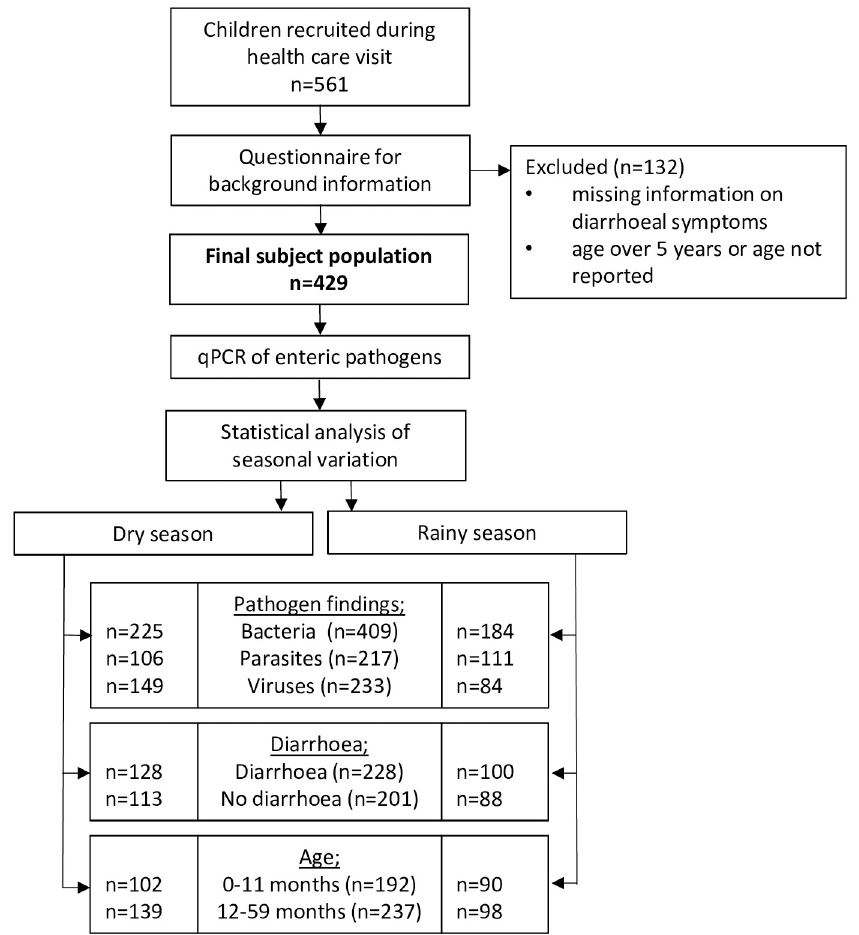
Fig 1. Flow chart of the study. The final study population comprised 429 children; 424 of these were tested for bacterial, 397 for viral, and 426 for parasitic pathogens.